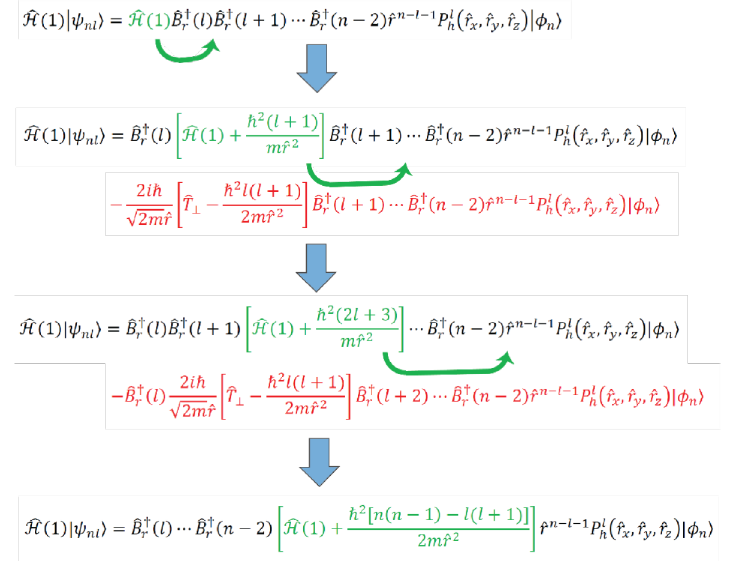
Figure 2. Schematic for how the energy eigenstate calculation